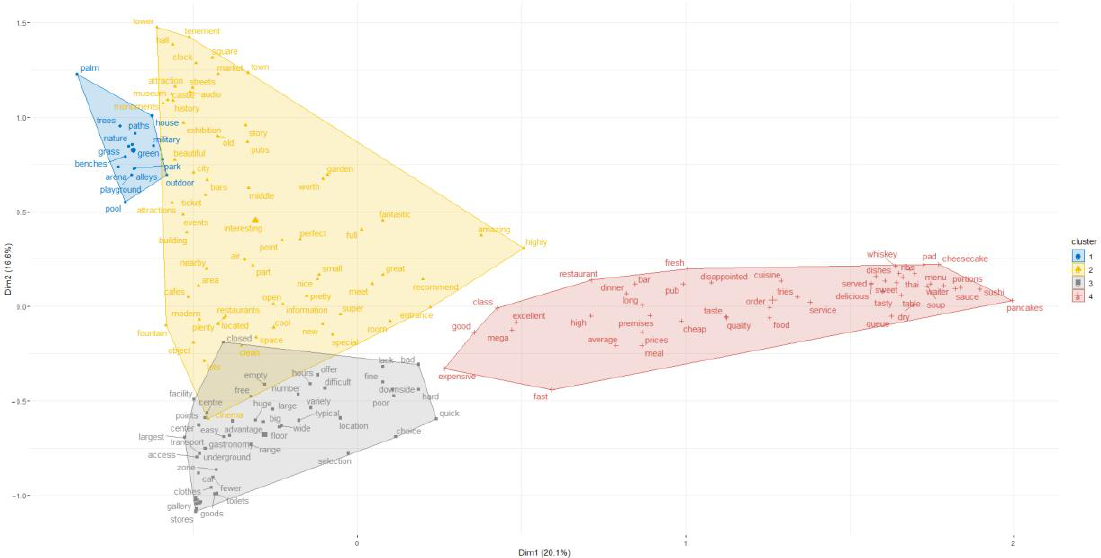
Figure 3. Hierarchical clustering of place attributes dimension terms. The x -axis and y -axis indicate percent of variance explained.